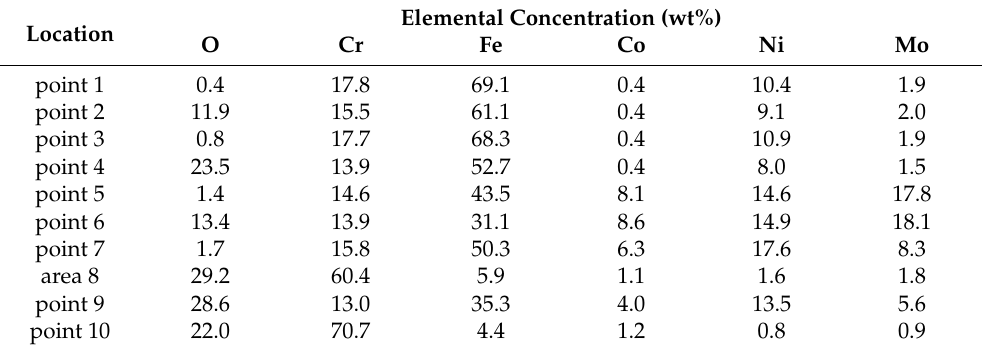
Table 7. Chemical composition of the HEA_Mo 20 and HEA_Mo 27 coatings deposited with the different coating techniques from EDX analysis after the dry sliding wear test. The EDX point and area spectra 1–10 are marked in the SEM images in Figure